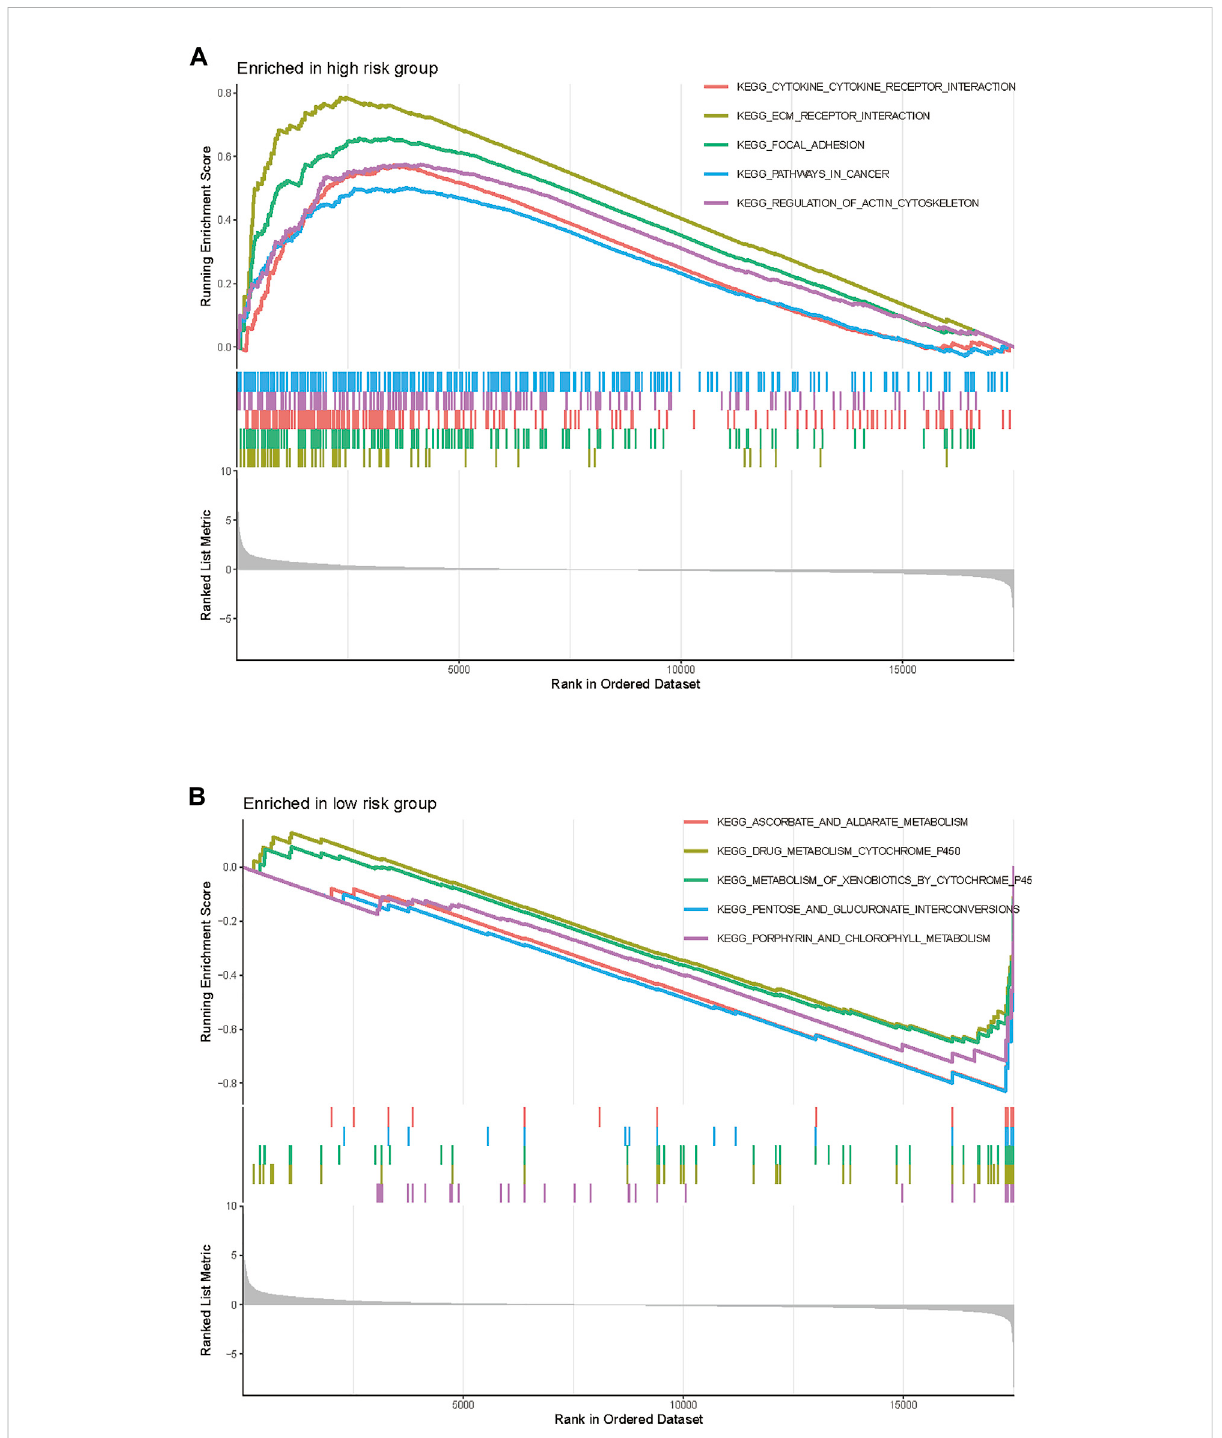
FIGURE 5 Gene Set Enrichment Analysis of the TME gene signature in TCGA-BLCA cohort. (A) The enriched gene sets in high-risk group (nominal p < 0.05). (B) The enriched gene sets in low-risk group (nominal p <